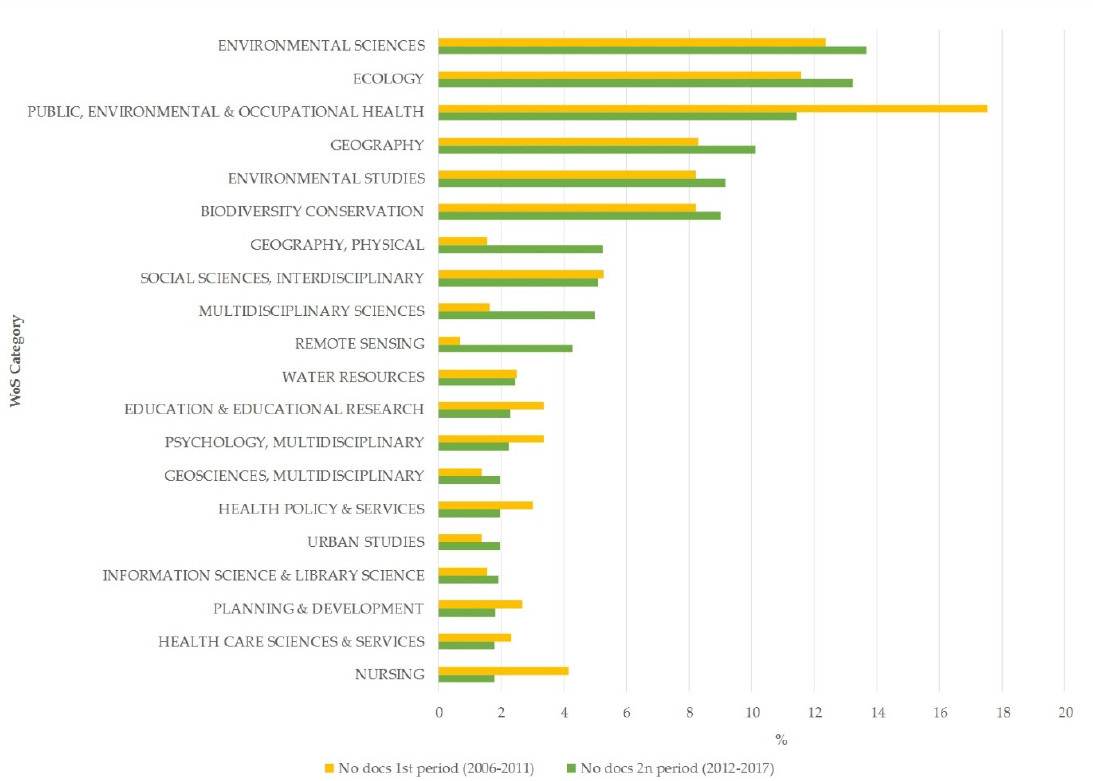
Table 3. Classification of publications by cluster.